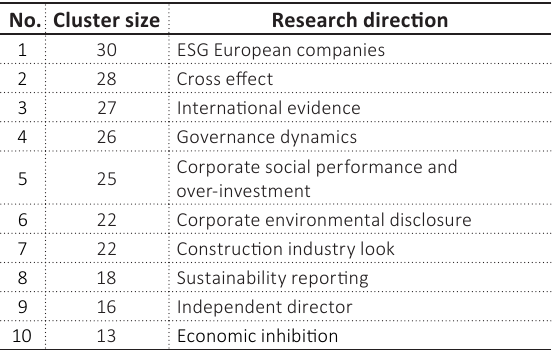
Table 8. Future research